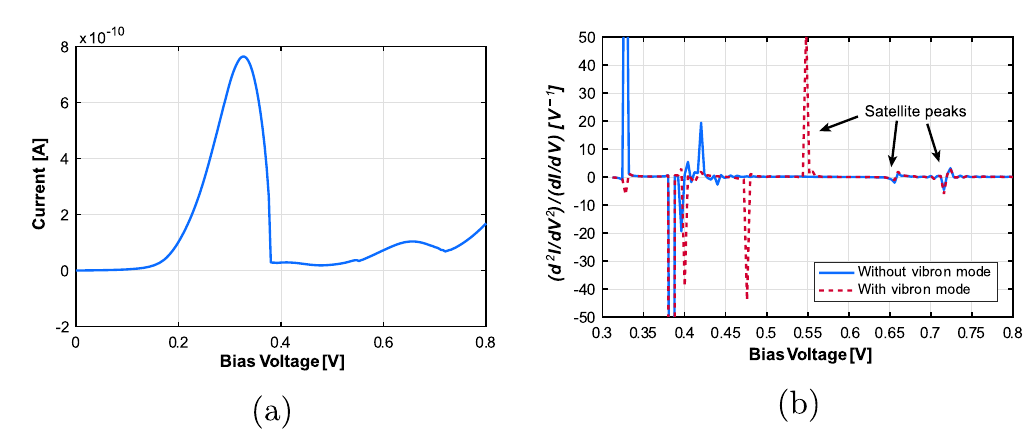
Figure 3. Current-voltage characteristics and IET spectrum for nanowire RTD with an odorant molecule attached to the emitter side barrier (bulk phonon mode energy ħ ω = 0.175 eV and vibron energy ħ ω f = 0.09 eV).